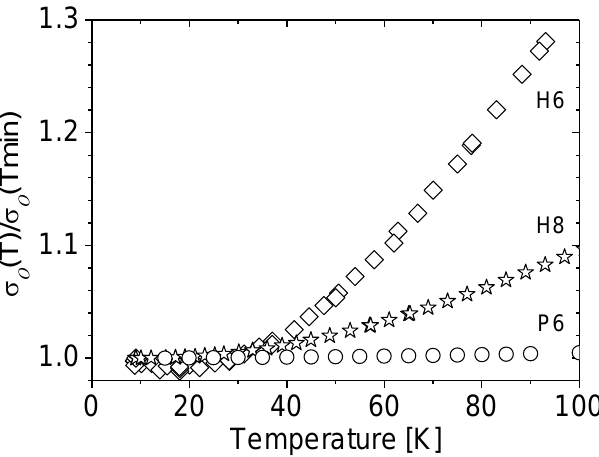
Figure 4. Relative variation of conductivity σ o ( T )/ σ o ( T min ) vs. temperature. Results for samples with different, increasing carrier concentrations: - n H = 3.1 × 10 18 cm − 3 (diamonds, sample H6); - n H = 1.1 × 10 19 cm − 3 (stars, sample H8); - n H = 1.2 × 10 20 cm − 3 (circles, sample P6).